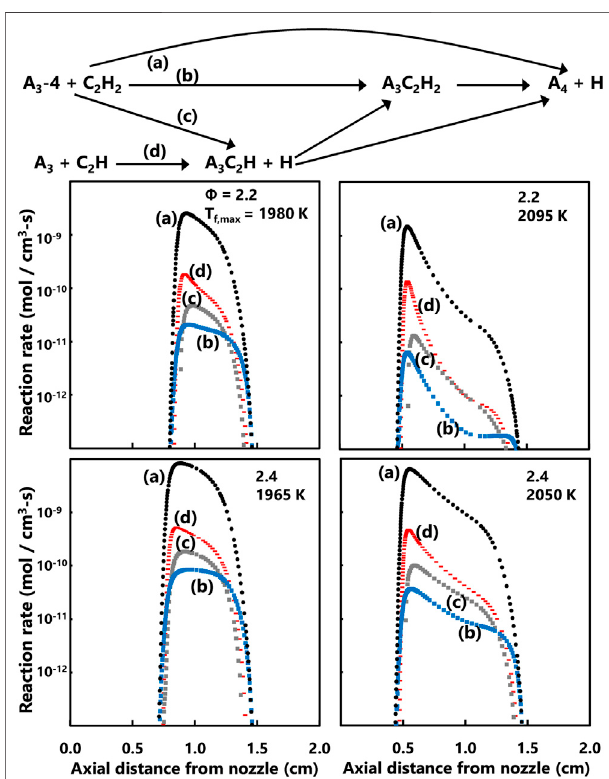
FIGURE 10 | Reaction pathways for production of pyrene (A4) considered by the ABF model (top) and axial pro fi les of computed reaction rates for four main pyrene production pathways (bottom)